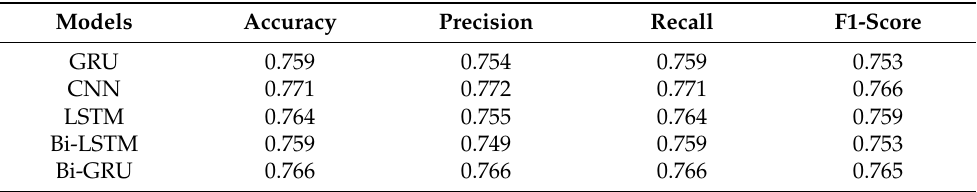
Table 5. Performance comparison of various models trained by the Instagram-crawling dataset.